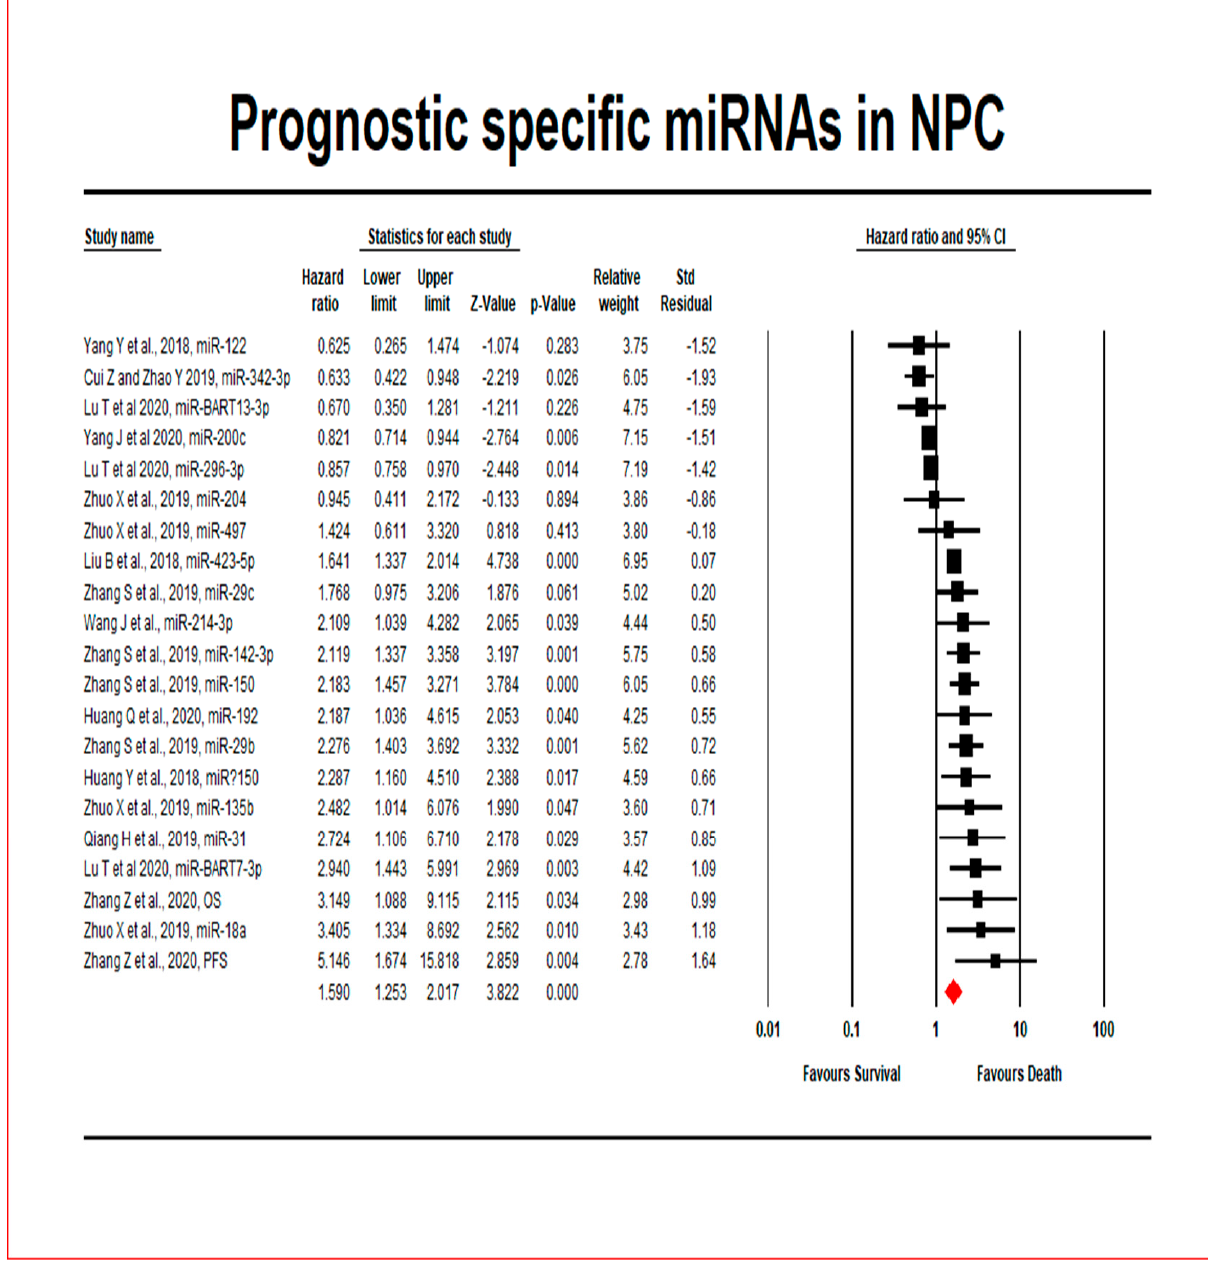
Figure 2. The survival outcome of miRNAs in NPC patients is represented by a forest plot.